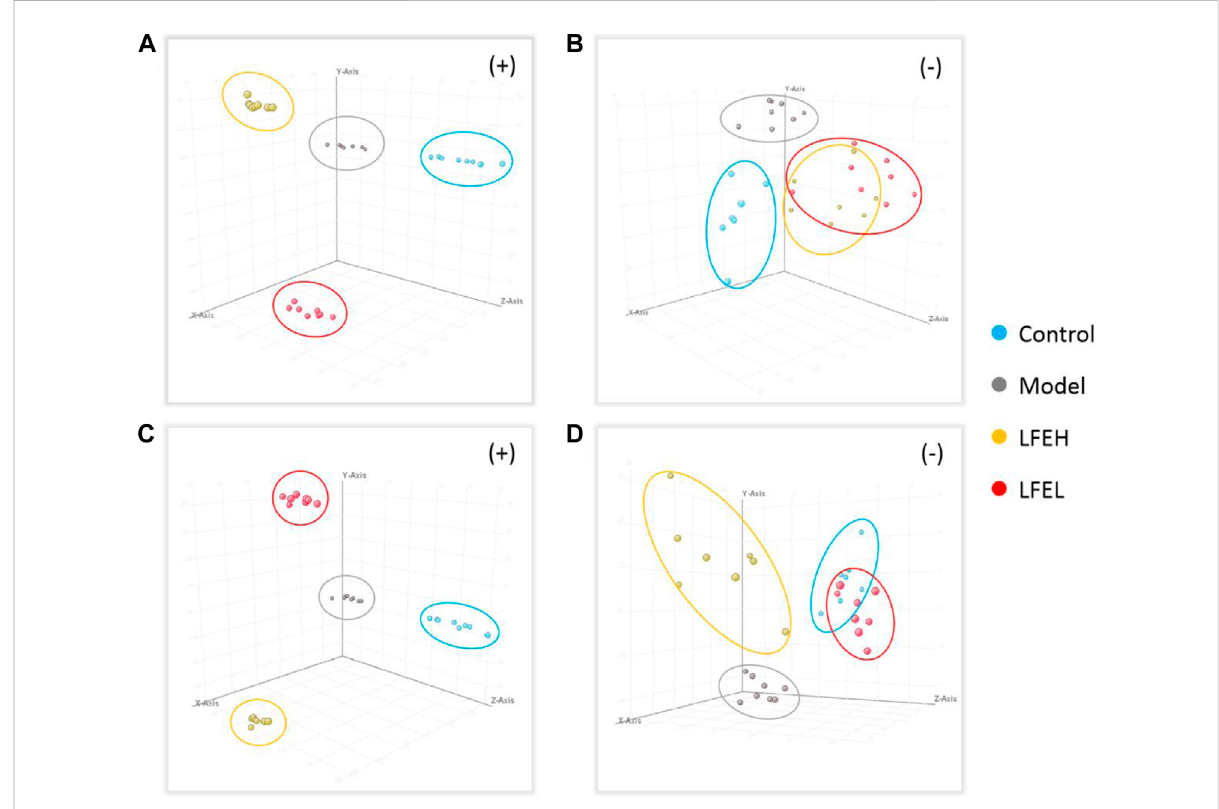
FIGURE 6 PCAandPLS-DAanalysis. (A) PCAanalysisinpositivemode. (B) PCAanalysisinnegativemode. (C) PLS-DAanalysisinpositivemode. (D) PLS-DA analysis in negative mode. Control, the blank group; Model, the model group; LFEH, LFE high-dose group; LFEL, LFE low-dose